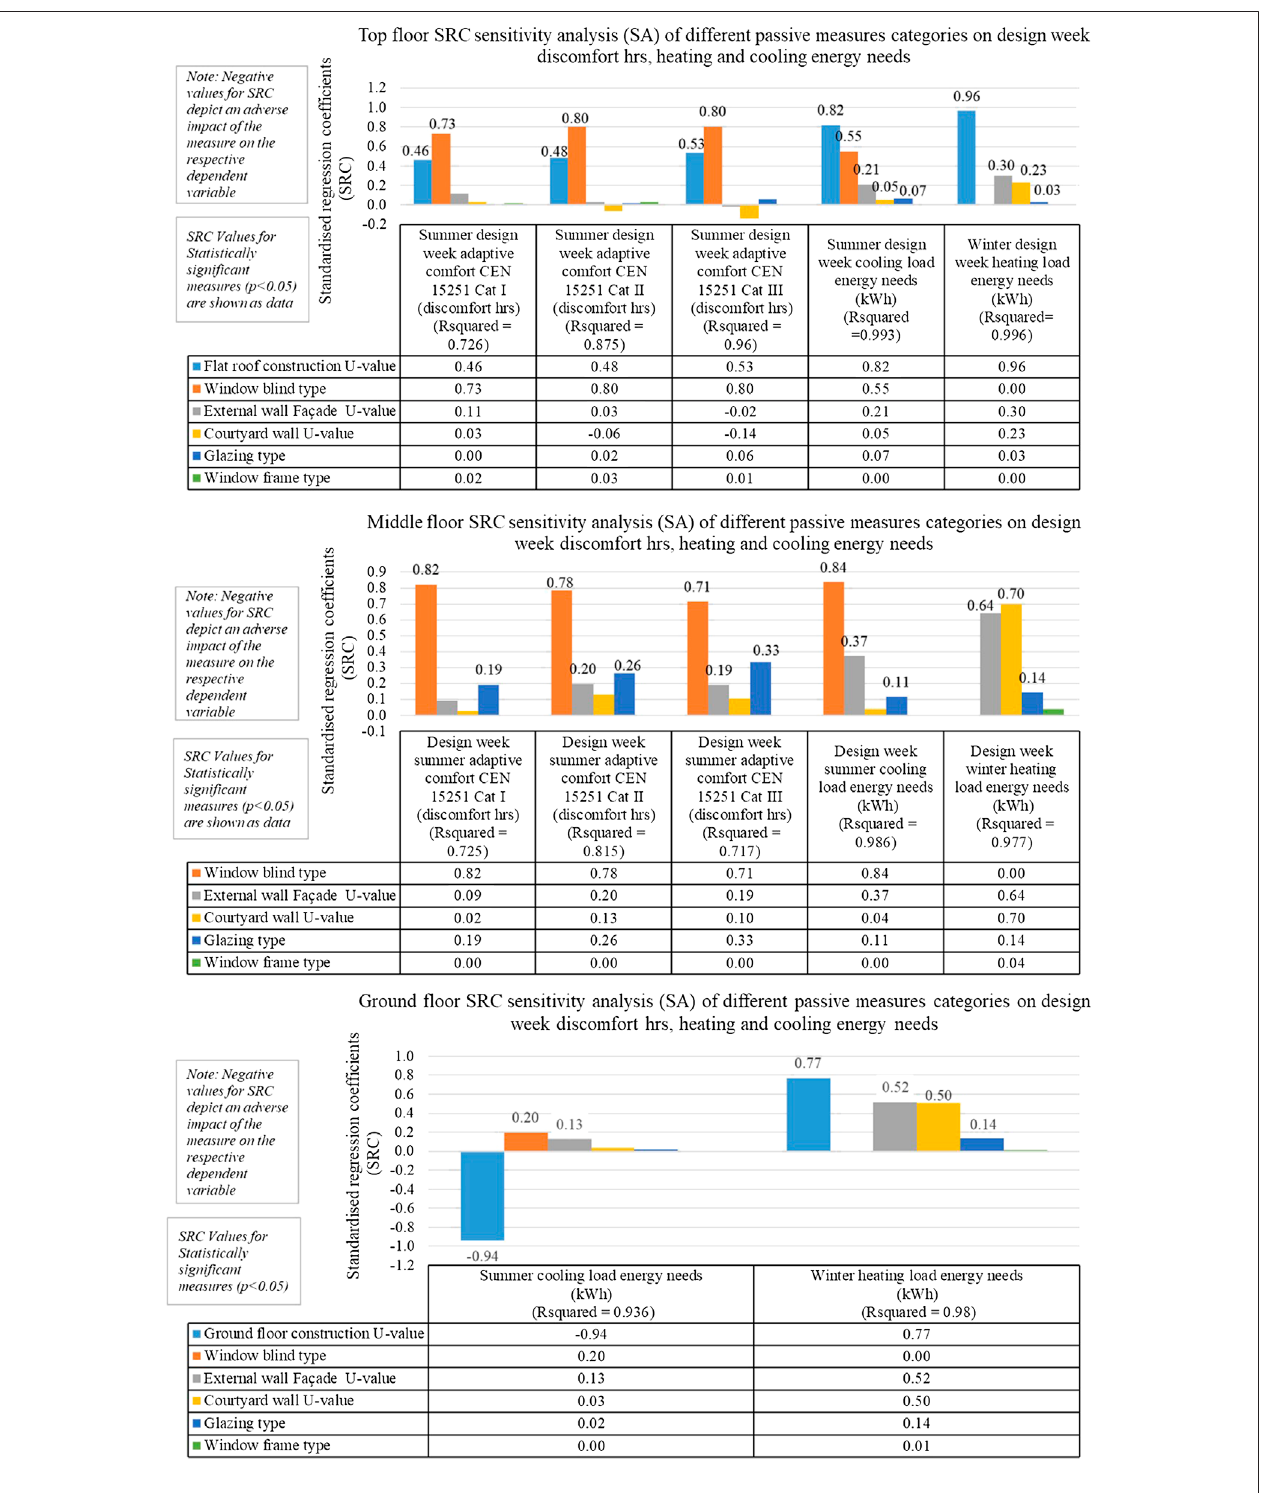
FIGURE 3 | Top (top image) , middle (middle image) , and ground fl oor (bottom image) global standardized regression coef fi cient sensitivity analysis plot of different passive measures on the adaptive comfort, heating, and cooling energy needs.